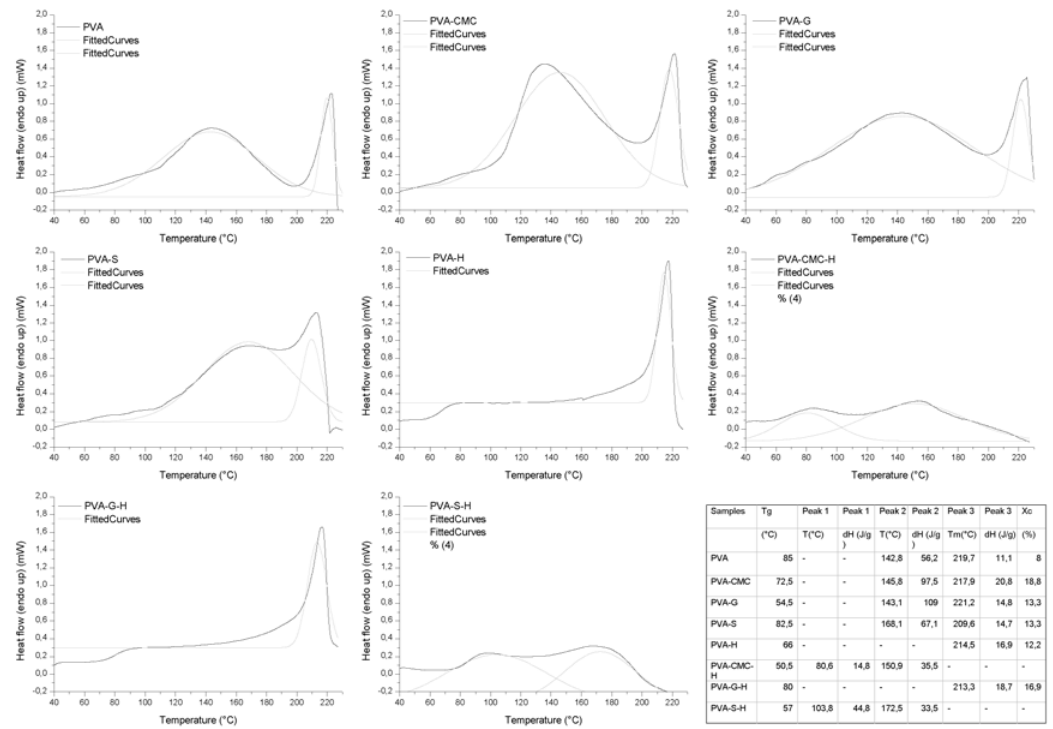
Figure 4. DSC curves of the samples. 457